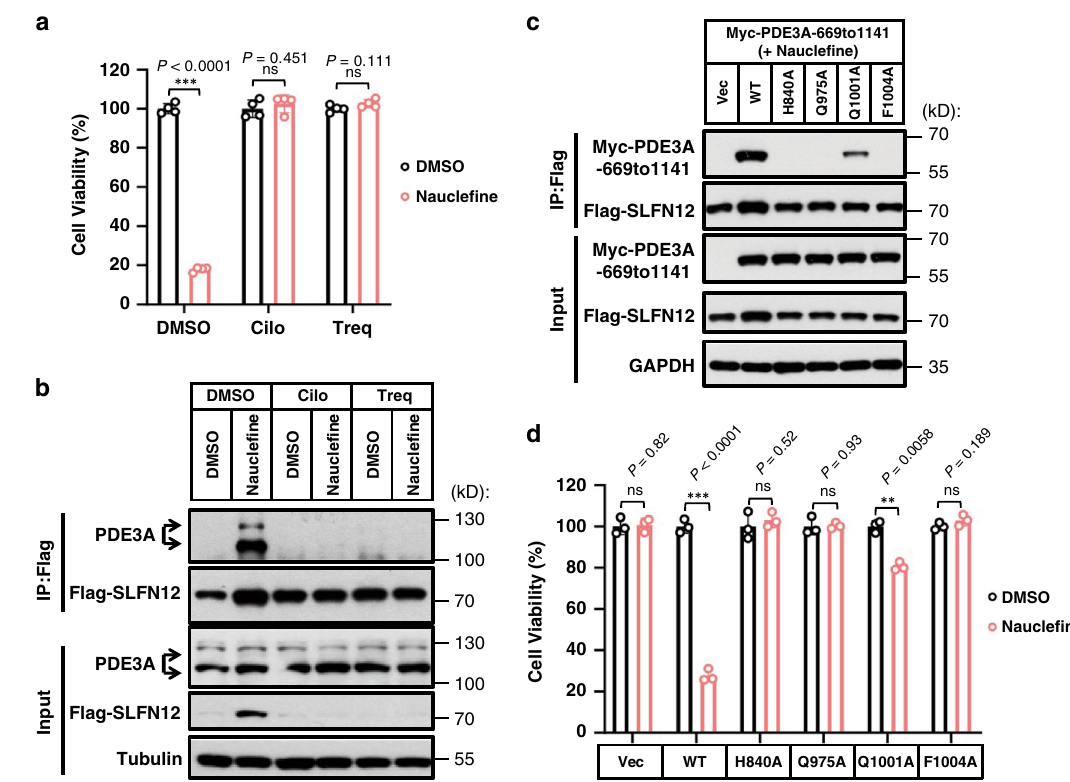
Fig. 4 Interaction between SLFN12 and PDE3A is required for naucle fi ne-induced cell death. a , b The PDE3 inhibitors cilostazol (1 µ M) or trequinsin (50 nM) were co-treated with naucle fi ne (200 nM) in HeLa cells with Flag-SLFN12 stably expressed. ATP levels were measured to assess cell viability a ( n = 4, examined in three independent experiments). This is a representative result (mean ± SD) and the p values from Student ’ s two-tailed unpaired t -tests are indicated. * p < 0.05; ** p < 0.01; *** p < 0.001; ns not signi fi cant. Cells were treated as in a for 20 h, followed by immunoprecipitation ( b ). Cilo denotes cilostazol, and Treq denotes trequinsin. c Flag-SLFN12 was transfected into HeLa cells stably expressed WT or mutant PDE3A. Naucle fi ne (200 nM) was then administered and cells were treated for 20 h, followed by immunoprecipitation. d The indicated cells were treated by naucle fi ne (200 nM) for 36 h, followed by assessment of cell viability based on cellular ATP levels ( n = 3, examined in two independent experiments). The western blots are representative of results from two independent